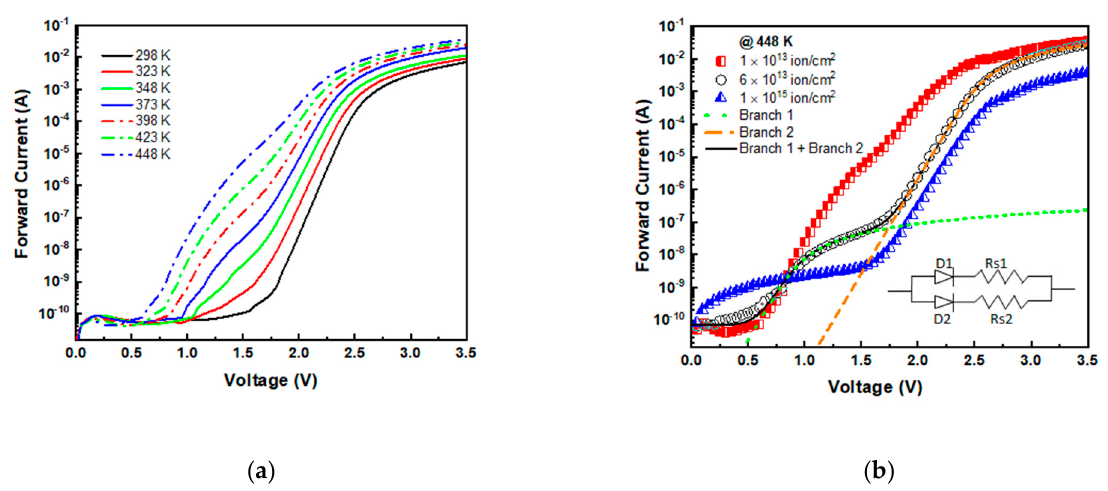
Figure 8. I–V characteristics at different temperatures for the 1.0 × 10 13 cm − 2 irradiated diode ( a ). I–V characteristic at 420 K for different fluence-irradiated diodes. The fit of the I–V characteristic with the parallel double diodes is reported for the 6.0 × 10 13 cm − 2 irradiated device. In the inset, a typical equivalent circuit of the studied p–n structure is sketched ( b ).